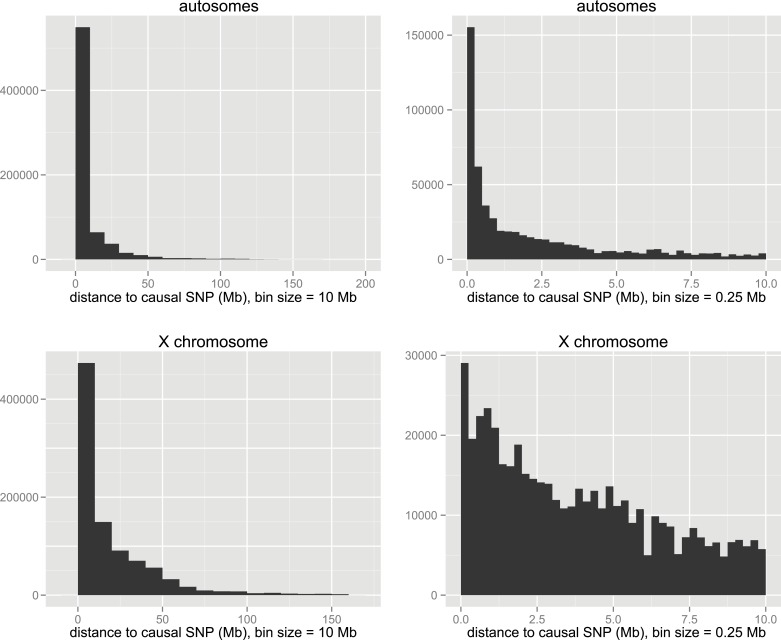
Distances of significant SNPs to causal SNP in simulations.Distributions are shown at two scales for autosomal and X-linked loci.